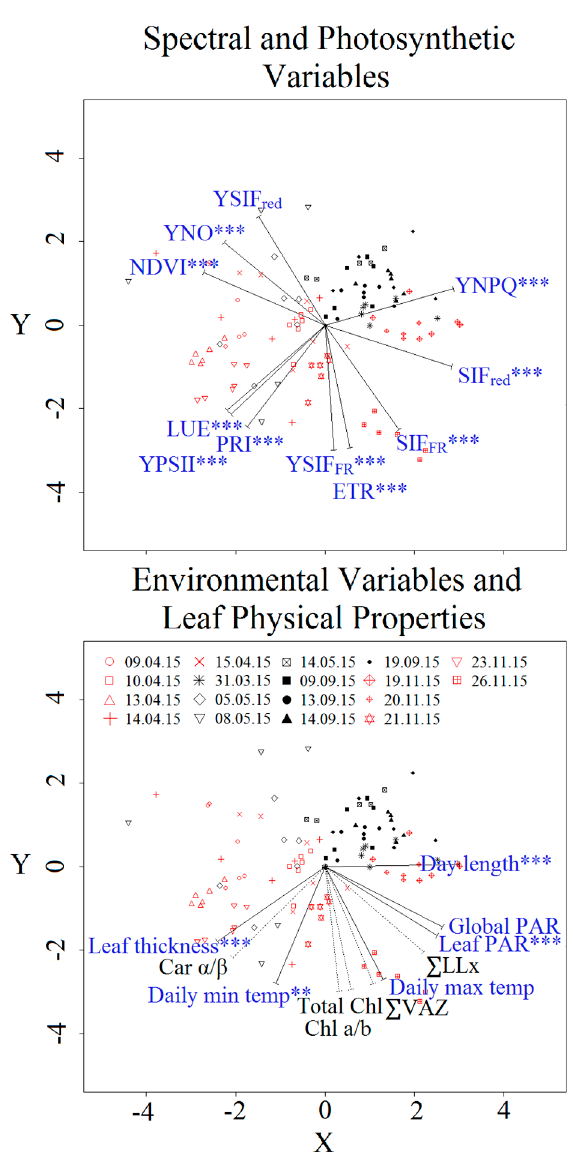
Figure 2. Two-dimensional multidimensional scaling (2D MDS) analysis of daily photosynthetic, physical, leaf pigment and remotely sensed measurements from leaves of avocado (red) and orange jasmine (black; stress = 0.16). Analyses were performed on the spectral and photosynthetic variables (electron transport rates (ETR), photosystem II yield (YPSII), non-photochemical quenching (YNPQ), constitutive heat dissipation (YNO), solar induced chlorophyll fluorescence (SIF); SIF red and SIF FR , YSIF red and YSIF FR , light use efficiency (LUE), normalized difference vegetation index (NDVI) and photochemical reflectance index (PRI)), with vectors calculated for the spectral and photosynthetic variables, the environmental variables (day length, global photosynthetically active radiation (PAR), leaf PAR, daily min air temperature (daily min temp) and daily max air temperature (daily max temp)) and the leaf physical properties (leaf total chl, Chl a/b, ∑ VAZ, ∑ LLx, Car α / β , leaf thickness). Measurement dates are marked by symbol type, with dates given in day/month/year format in the legend. Data points between the 31.03.15 to 19.09.15 represent University of Wollongong, Ecology Research Centre (UOW) grown plants, whereas dates between 19.11.15 to 26.11.15 represent orchard grown plants from Summerland House Farm (SHF). Where data were available for both avocado and orange jasmine leaves, vectors are shown as solid lines and vector names are in blue. Where data was only available from avocado leaves (leaf pigments), vectors are shown as broken lines and vector names are in black. Significant vectors are marked by *, where *** p < 0.001 and ** p ≥ 0.001 & p < 0.01. All vectors have been scaled by a factor of three to facilitate visualization.